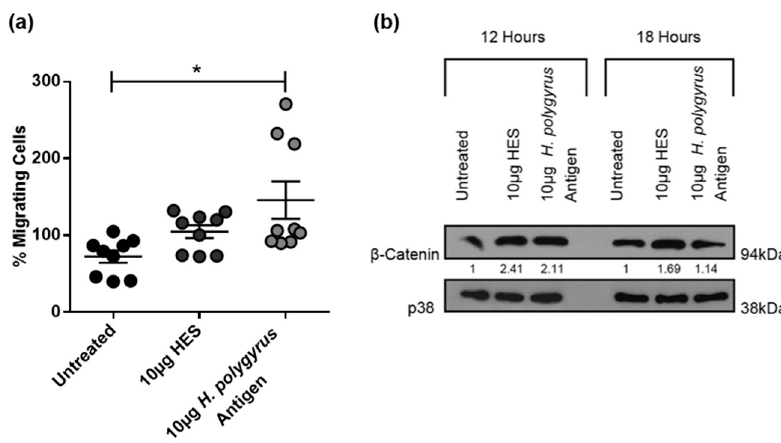
Figure 4. H. polygyrus -derived antigens increase murine colorectal cancer (CRC) cell migration and β - catenin expression. ( a ) Transwell migration assay of untreated control and CT26.WT cells exposed